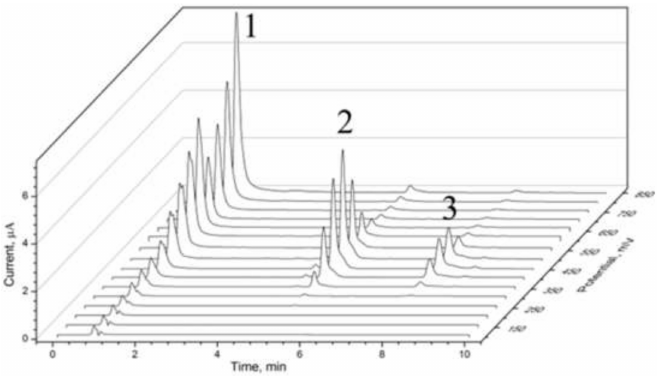
Figure 2. Current signal of the Habanero pepper extract from the 16 CoulArray channels poised at poten- tials from +100 to +850 mV with a step of 50 mV: (1) unknown peak; (2) capsaicin; (3) dihydrocapsaicin.